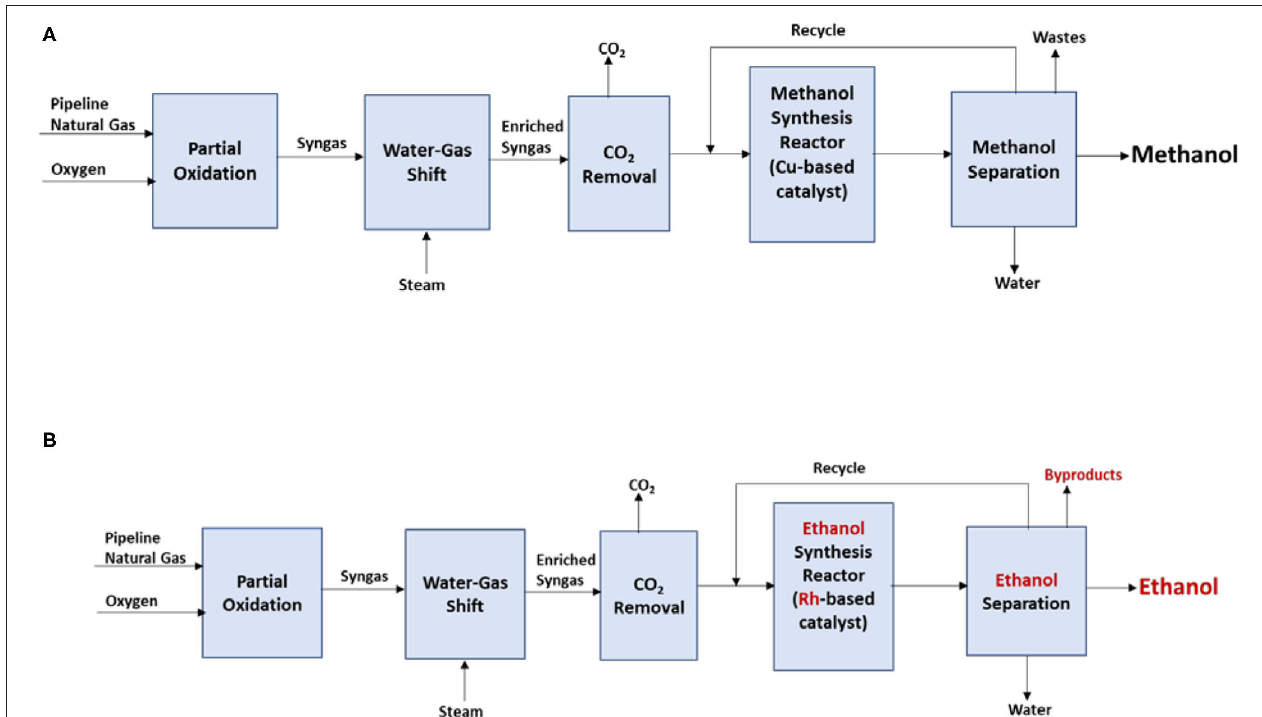
FIGURE 7 | (A) A methanol production process. (B) A repurposed process for the production of ethanol.